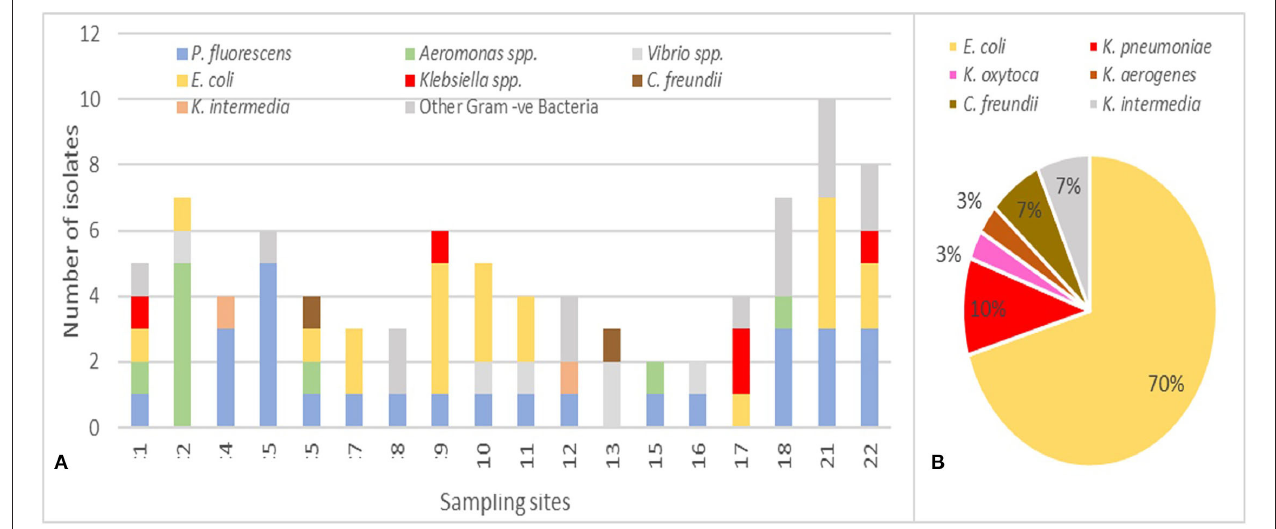
FIGURE 5 | (A) Distribution of the 87 bacterial species identified in the 18 sampling sites. (B) Distribution of Enterobacterales spp. (values are in %, n = 30) with E. coli representing 70% of the